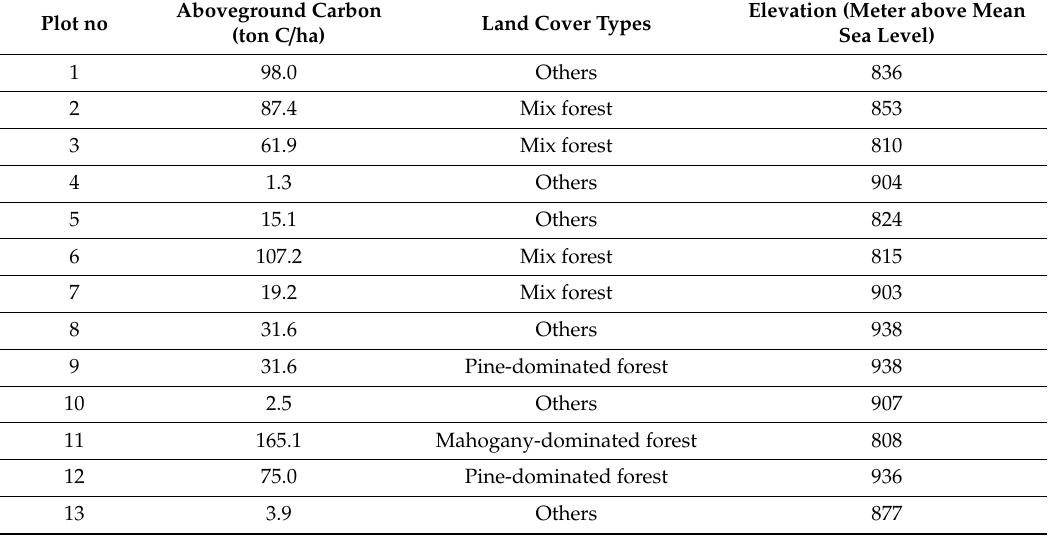
Table A1. Aboveground carbon data from 95 sampled plots in the Geulis Mountain